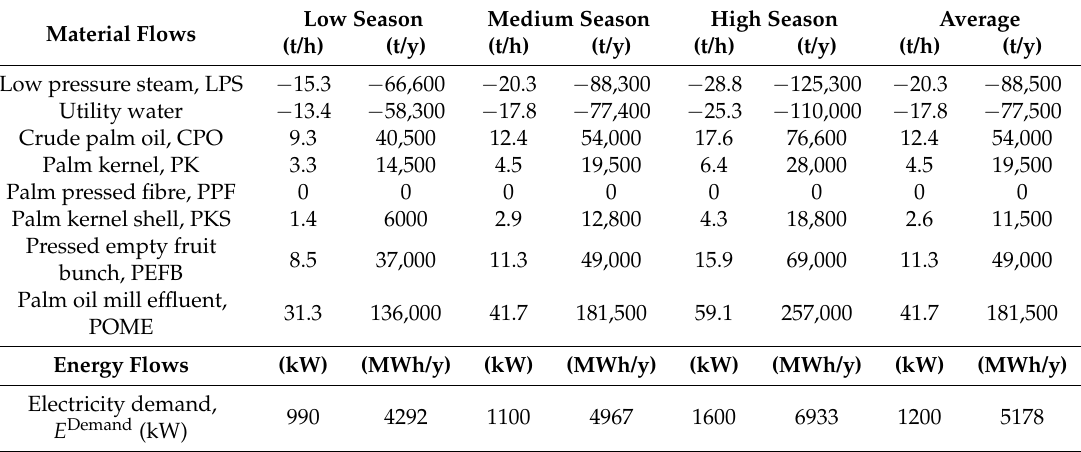
Table 3. Material and energy flows for baseline POM design.